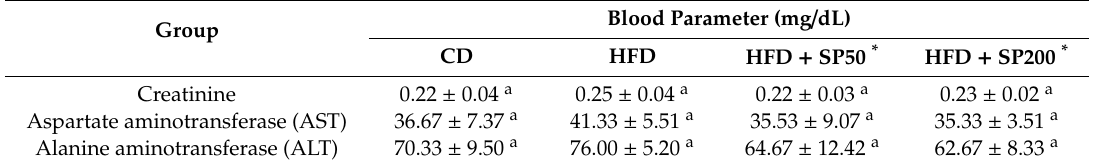
Table 2. E ff ect of SP treatment on the blood parameter in HFD-fed mice.